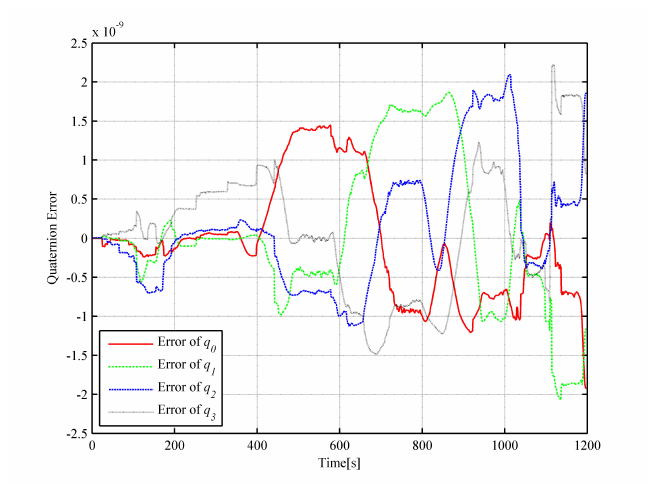
Figure 7. Curve of the quaternion error (based on the quaternion).